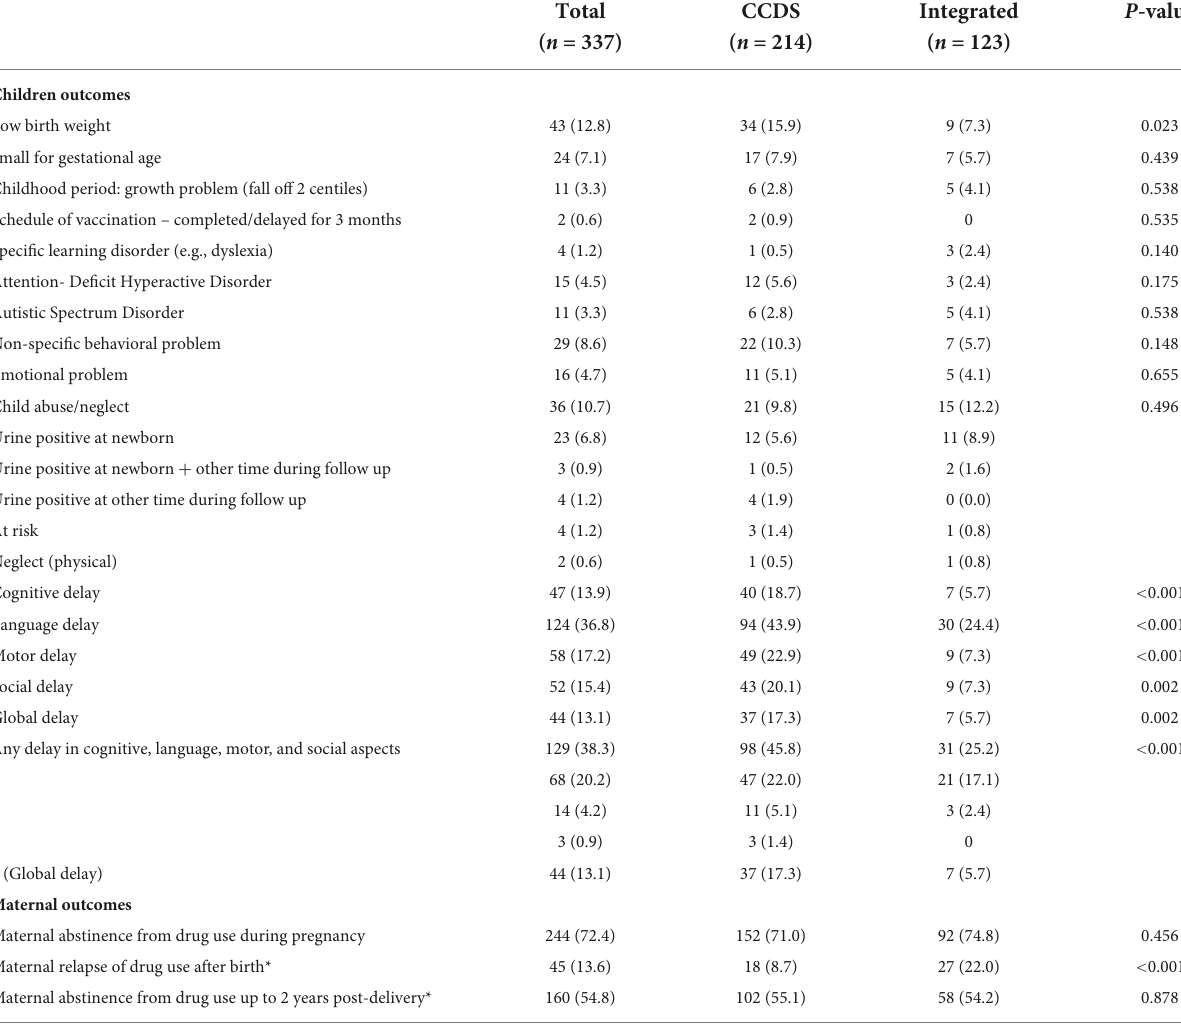
TABLE 2 Children and maternal